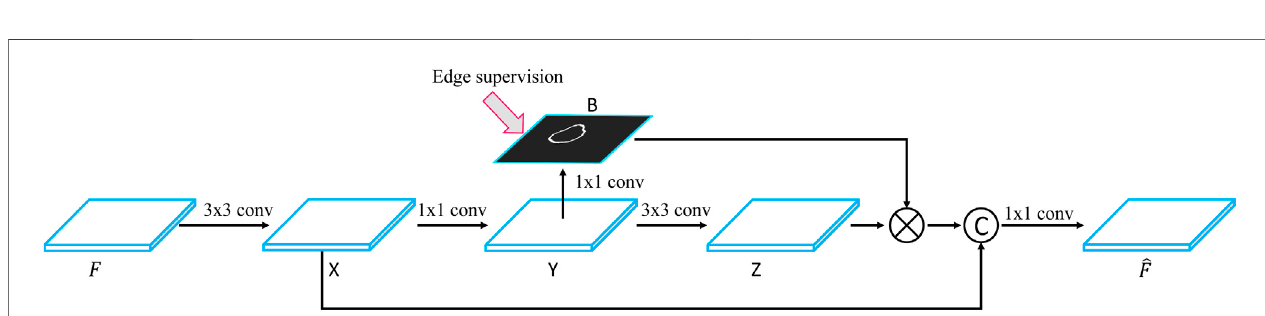
FIGURE 2 | Schematic illustration of the proposed approach for breast lesion segmentation from ultrasound images. Please refer to Figure 3 for BGFE module. Best viewed in color.